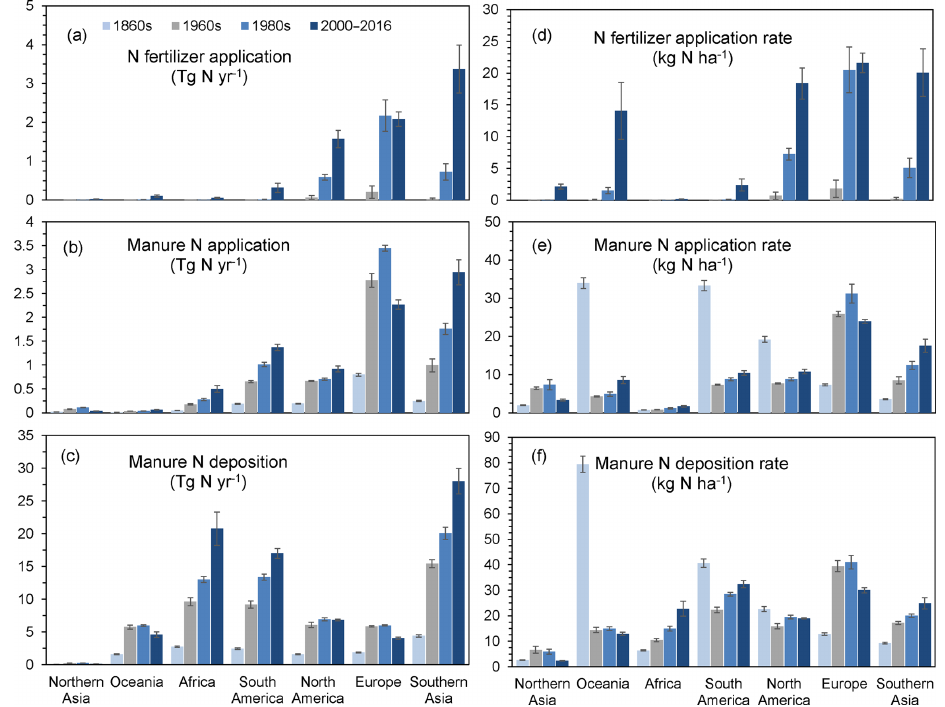
Figure 5. Nitrogen fertilizer use (a) and rate (d) , manure N use (b) and rate (e) and manure N deposition (c) and rate (f) at regional scales in the 1860s, 1960s, 1980s and 2000–2016. Error bars represent standard deviation within each